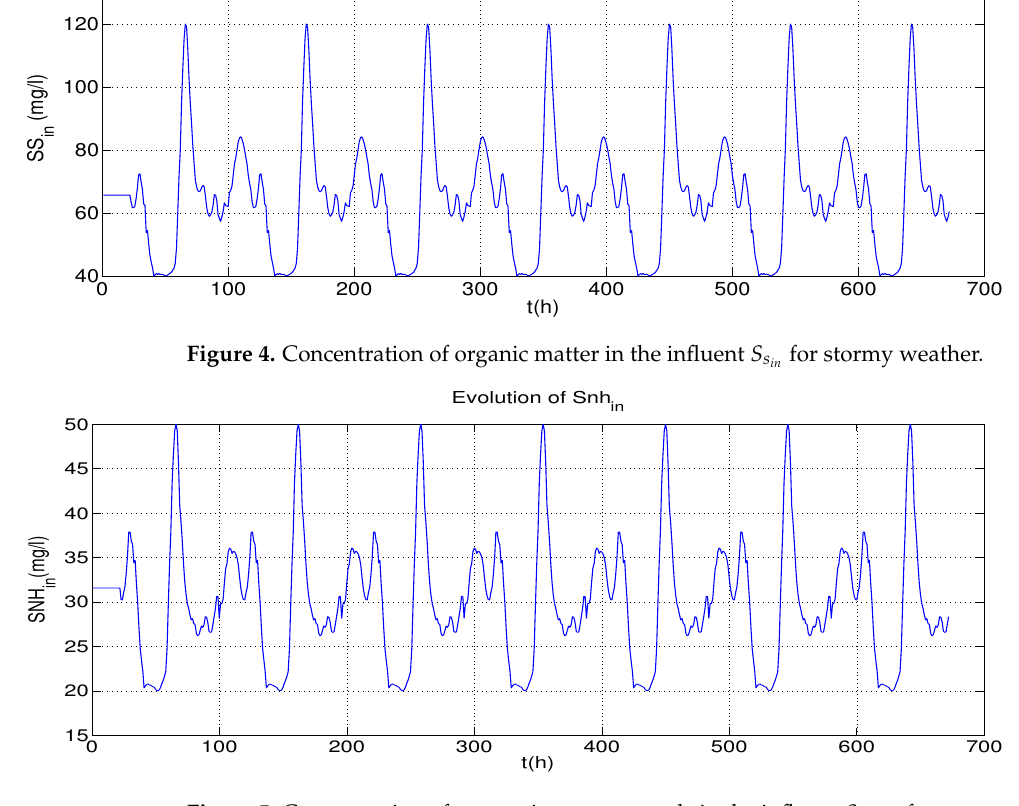
for stormy weather. in